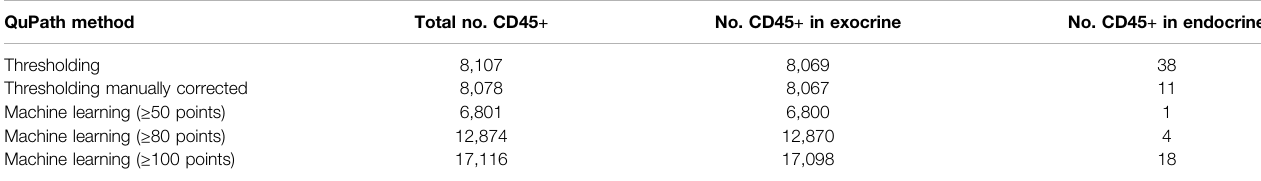
TABLE 2 | Comparison of the number of CD45+ cells in the whole tissue, the exocrine and endocrine area of slide #1, depending on the detection method (thresholding vs. machine learning). QuPath method Total no. CD45 + No. CD45 + in exocrine No. CD45 + in endocrine